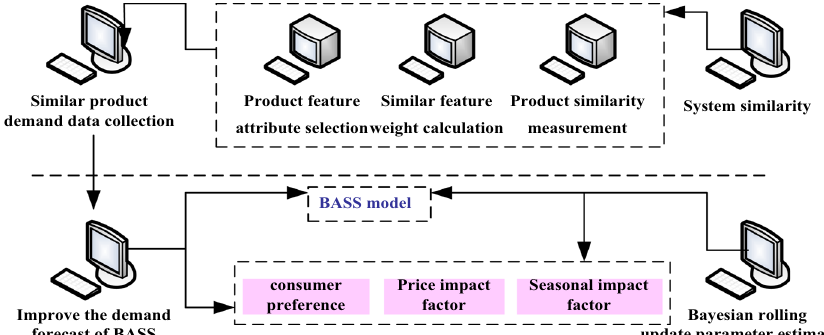
Fig. 7 The construction of a short life cycle product demand model system based on the improved BASS